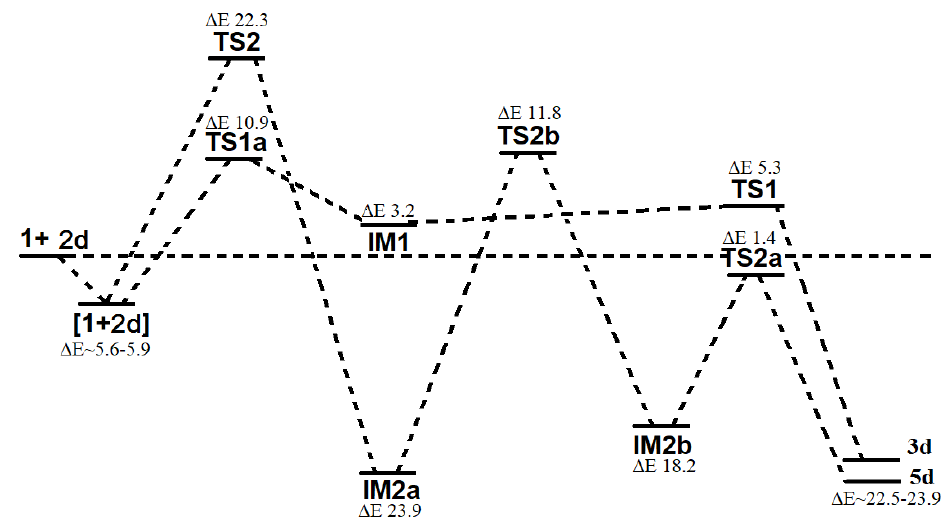
Figure 3. Energy diagram ( Δ E, kcal/mol) of the reaction of 4,6 ‐ dichloro ‐ 5 ‐ nitrobenzofuroxan 1 with 2 ‐ morpholinoethanamine 2d